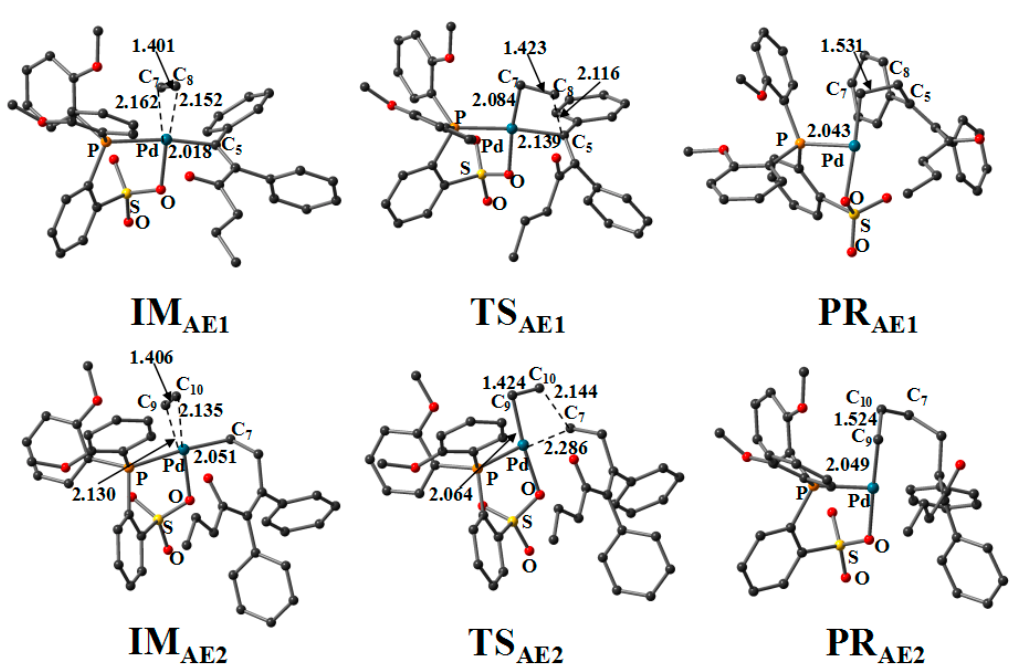
Figure 6. Optimized structures for continuing ethylene insertion reaction pathway shown in Figure 5, the key length is in angstroms. For clarity, the hydrogen atom is omitted.